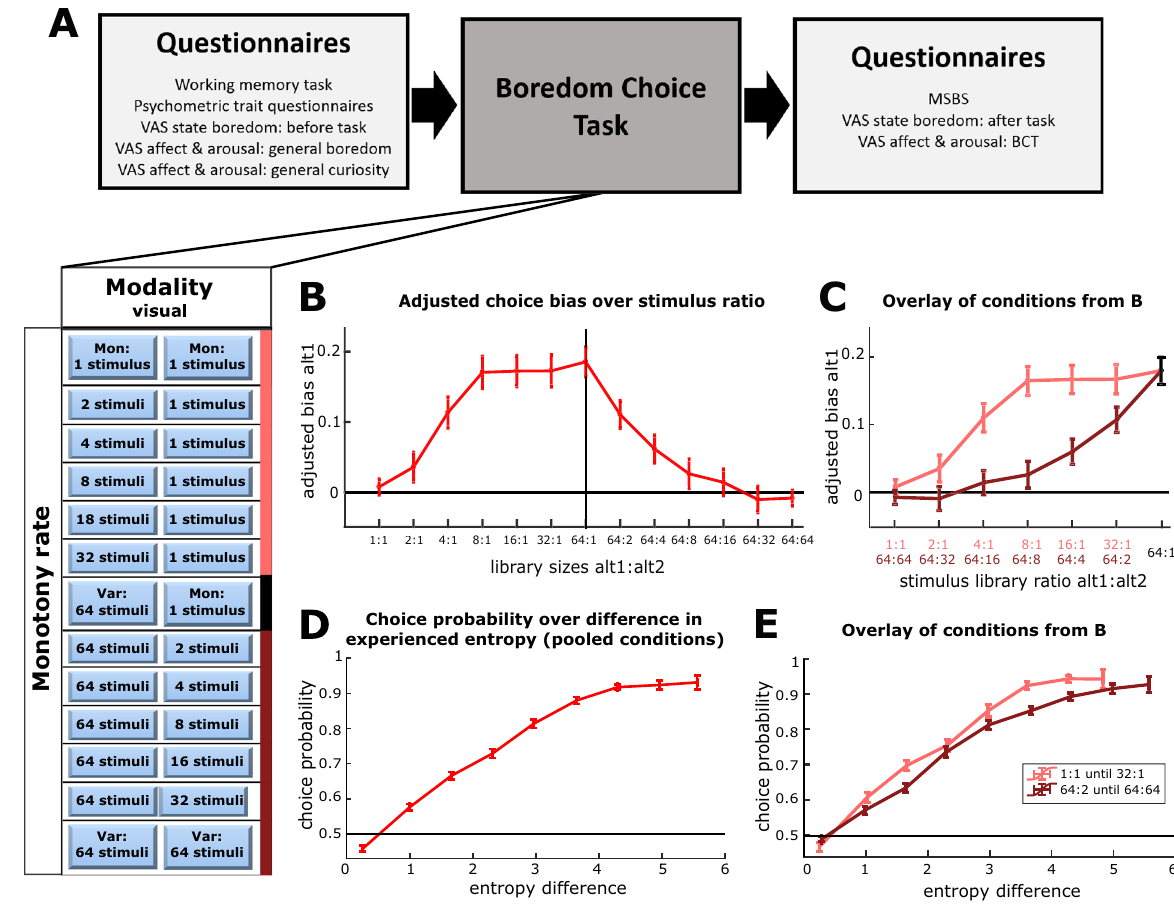
Figure 4. Boredom bias at varied degrees of monotony and its link to empirical entropy: ( A ) Procedure of Experiment II and the corresponding stimulus library ratios of each task cycle. Subjects underwent all 13 conditions in a randomized order. ( B ) The average adjusted boredom bias is computed over all subjects from Experiment II (n = 148) for each of the 13 stimulus library pairings. The vertical bars indicate the standard error of the mean. ( C ) The same adjusted boredom bias data from B is plotted over the ratio of stimulus libraries with both sides of the previous plot (1:1 to 32 and 64:64 to 2) overlaid. Here, both sets of conditions show an incongruent shape, despite equivalent library ratios. ( D ) Average probability of choice for one alternative presented over the previously experienced difference in entropy for this alternative. Thereby, entropy difference and the consecutive choice probability is computed for all trials in all BCT cycles of each subject’s (99 choices per 13 cycles resulting in 1287 pairs of data per subject). For negative values of entropy difference , the data pairs are inverted, leading to only positive values of entropy difference . Next, the data pairs of each subject are sorted into 9 equally spaced bins in the range of [0, 6] according to their entropy difference value and choice probability is computed over the choice data of each bin. Finally, the binned entropy difference and choice probability are averaged over all 148 subjects, leading to the plotted curve. The bars indicate the standard error of the mean (horizontal bars are vanishingly small). ( E ) In analogy to D, the entropy difference and consecutive choice probability is computed for each trial, where the data is grouped into two sets of different task conditions that in C showed high divergence (1:1 to 32:1 versus 64:2 to 64:64). In line with the previous procedure, we analyze entropy difference and the consecutive choice for each subject in the two sets of conditions (99 trials per 6 cycles resulting in 594 data pairs for each condition set). For negative values of entropy difference , the data pairs are inverted, leading to only positive values of entropy difference . For each subject the data is sorted into 9 evenly equally spaced bins in the range of [0, 6] according to the experienced entropy difference and the choice probability is calculated for each bin. The individual data of all 148 participants is then averaged leading to the plotted curves. Different from ( C ), both sets of conditions show a widely congruent relationship between experienced entropy difference and consecutive choice probability